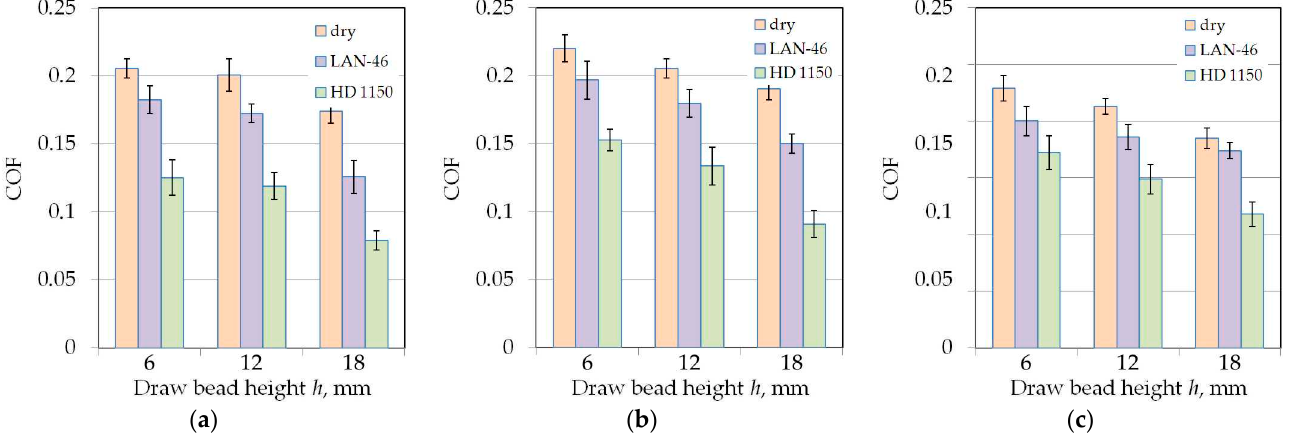
Figure 17. The effect of friction conditions on the value of COF for specimens cut transverse to the sheet rolling direction (orientation 90°) tested using countersamples with a surface roughness of Ra = 0.32 μ m: ( a ) w = 7 mm, ( b ) w = 14 mm, ( c ) w = 20 mm.